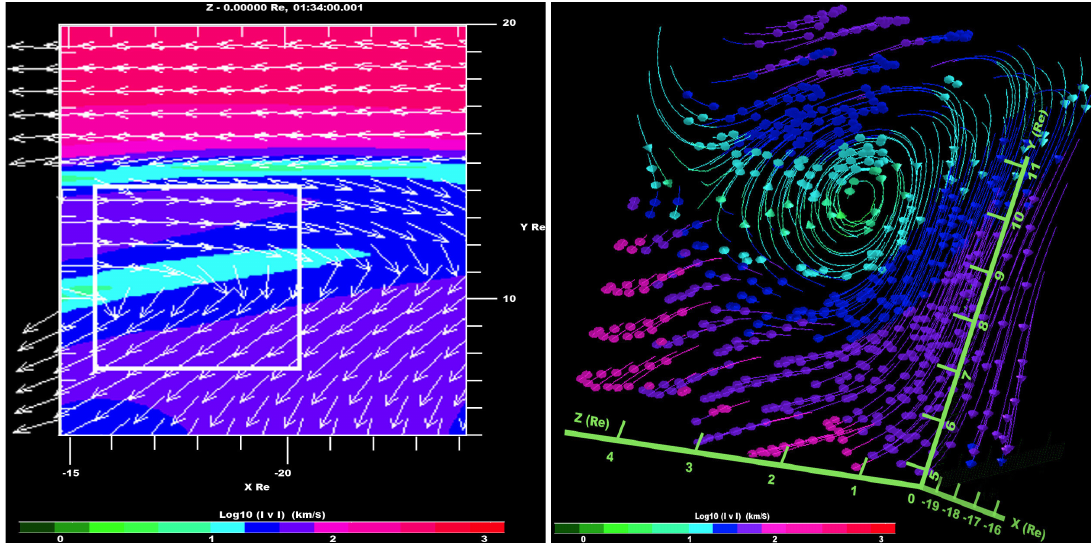
Fig. 1. Example of a vortex which would not be obvious with the naked eye, but that is correctly found with our algorithm. The colors represent the velocity magnitude in log scale and the arrows represent the flow vectors. The left panel is 2-D in the z = 0 cut plane on the duskside where the vortex is located. The right panel is the 3-D view of the vortex rotating approximately on the x